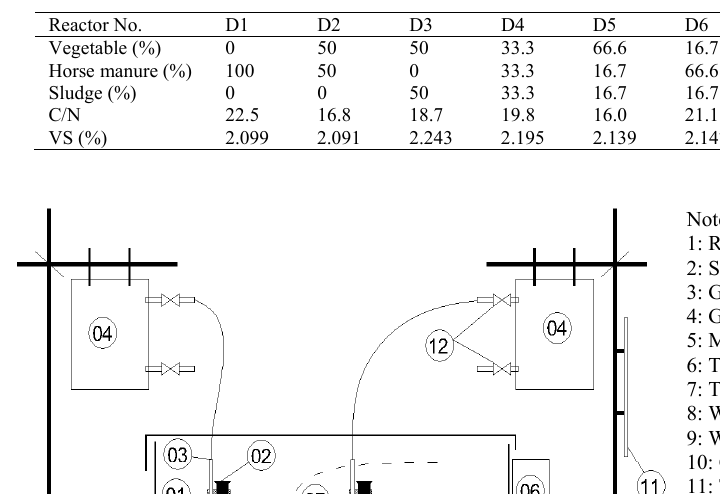
Table 2: Characteristics of the substrate inside the reactors